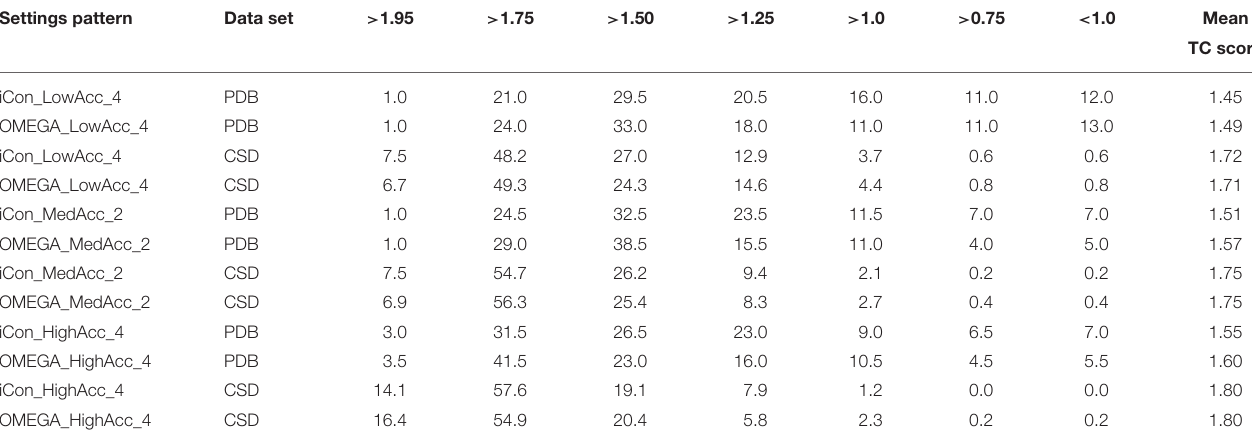
TABLE 6 | Percentage spreading of TC score values calculated for conformers of PDB and CSD compounds generated by iCon and OMEGA using three representative setting patterns. Settings